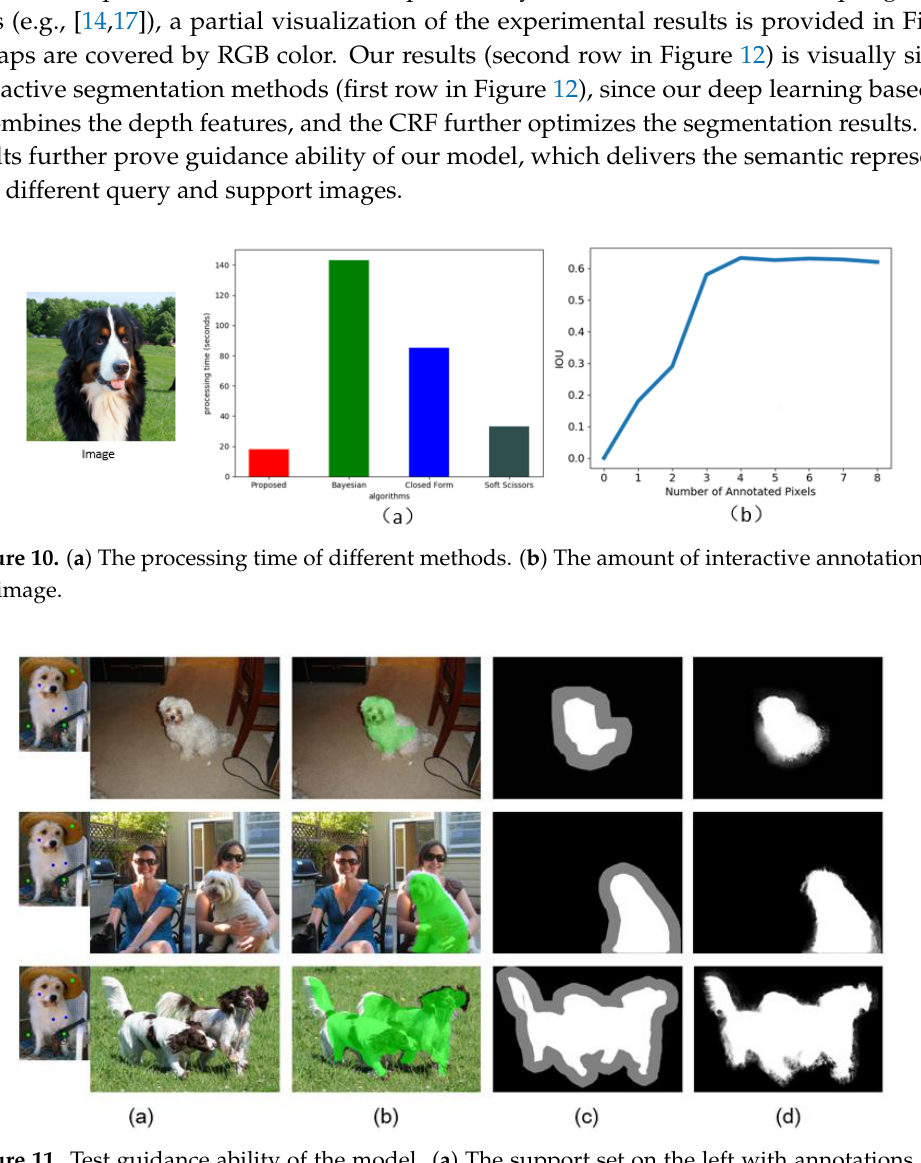
Figure 11. Test guidance ability of the model. ( a ) The support set on the left with annotations and the query set on the right; ( b ) one-shot semantic segmentation result, the query image is overlaid with our predicted result in green; ( c ) generated trimaps, and ( d ) our predicted alpha matte using ( c ) by [13]. First row, different spatial position. Second row, different foreground objects. Last row, multiple foreground